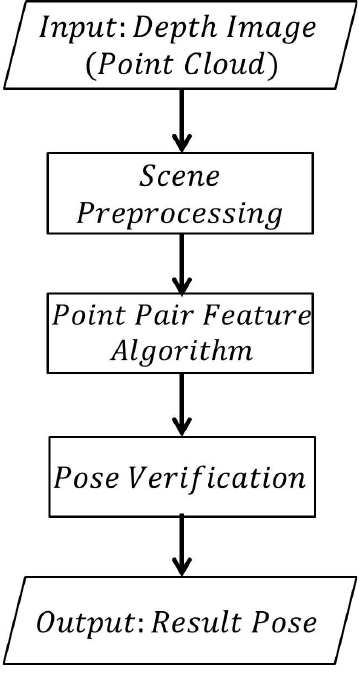
Figure 1. Pipeline of our algorithm.